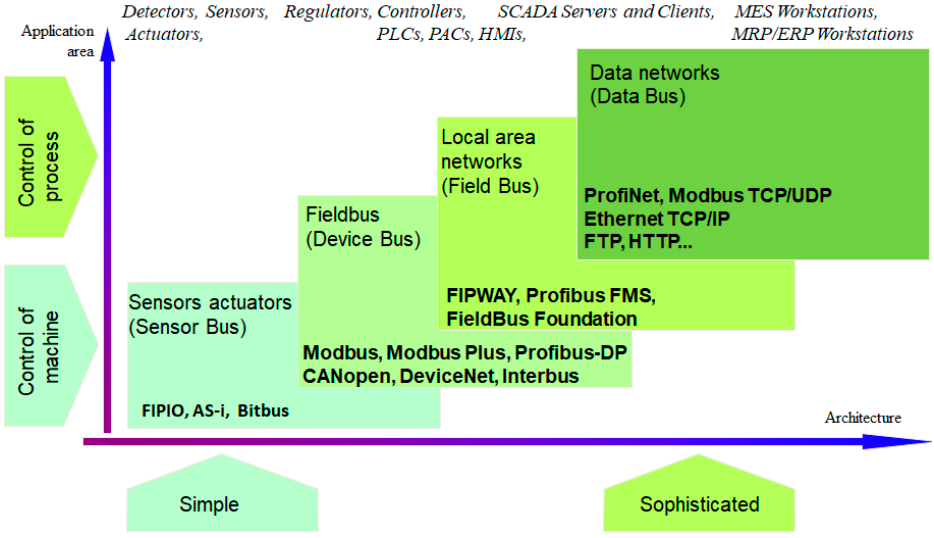
Figure 2. Location of the main industrial networks and buses—the areas of application